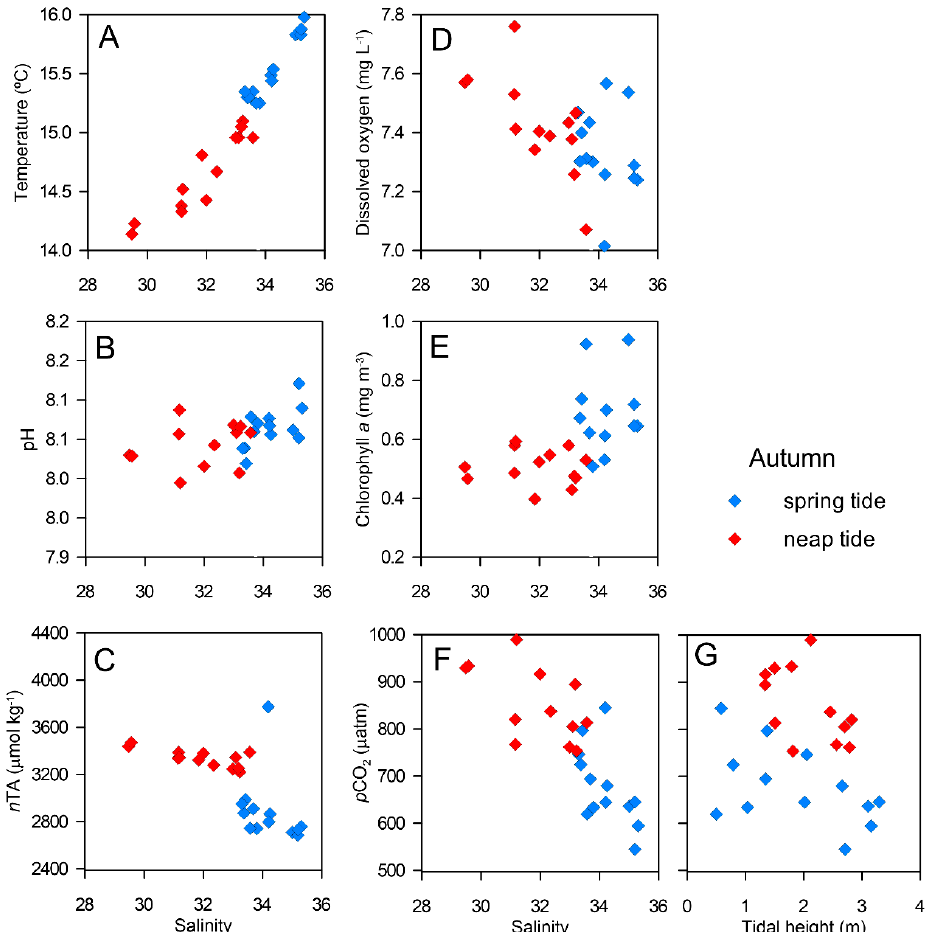
Figure 4. Autumn 2007 data for ( A ) temperature, ( B ) pH, ( C ) normalized alkalinity ( n TA), ( D ) dissolved oxygen, ( E ) chlorophyll a , ( F ) CO 2 partial pressure ( p CO 2 ), and ( G ) p CO 2 versus tidal